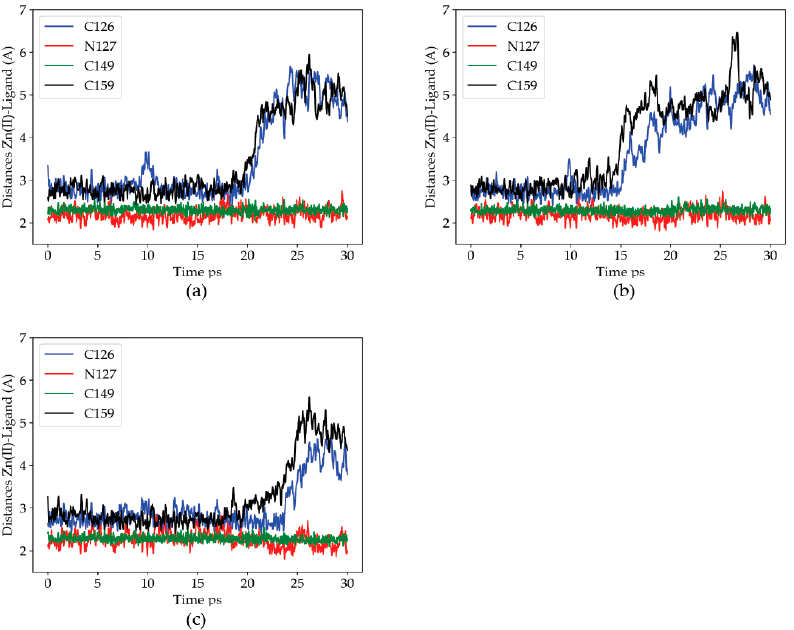
Figure 2. Distances for the identified Zn(II) ligands to the metal ion along each of the three 30 ps QM/MM MD trajectories for the C132A mutant of the P2X4R head domain. ( a – c ) Zn(II)-Ligand distances for three different trajectories. Blue: C126, Red: N127, Green: C132, Black: